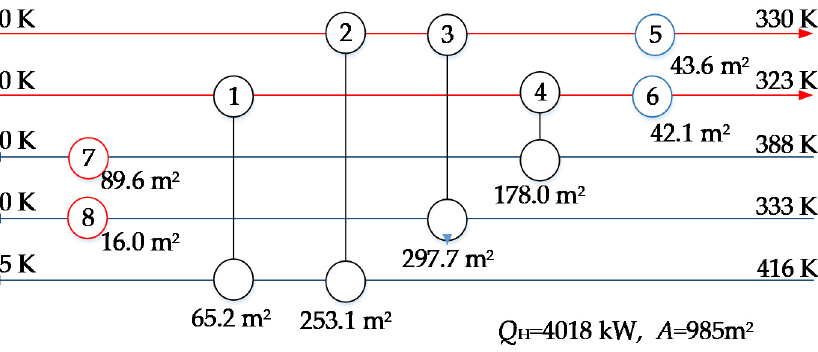
Figure 8. Optimal network of heat exchangers determined by multi-scenario stochastic approach (equal time periods).